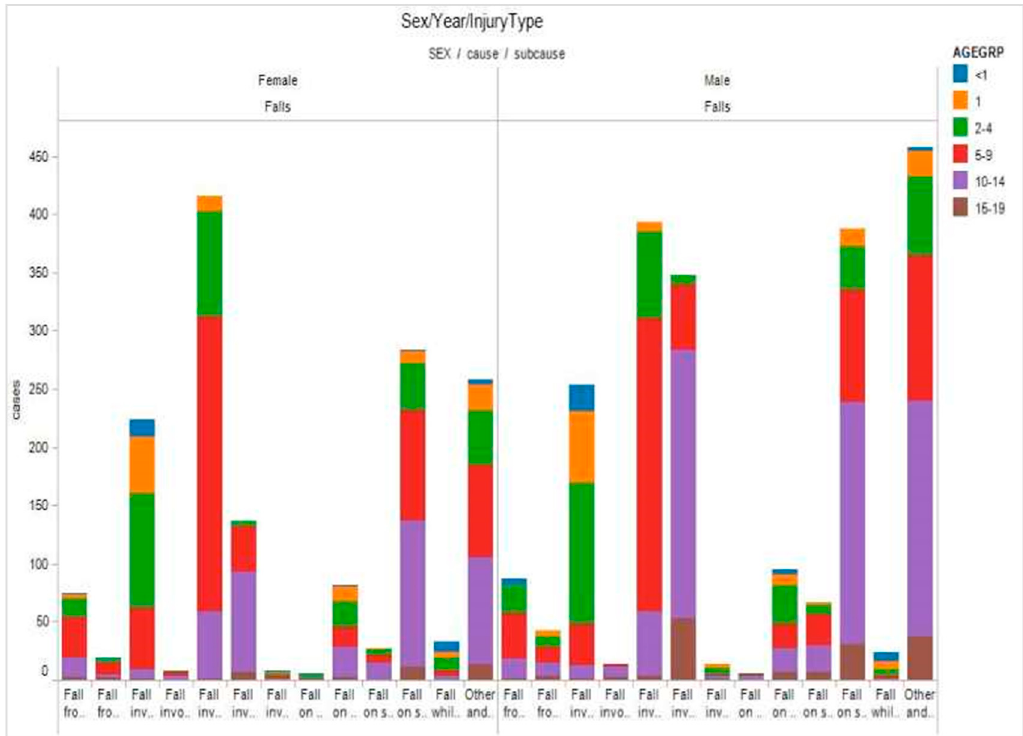
Figure 3. Brushing and linking (sex/injury causes/injury).